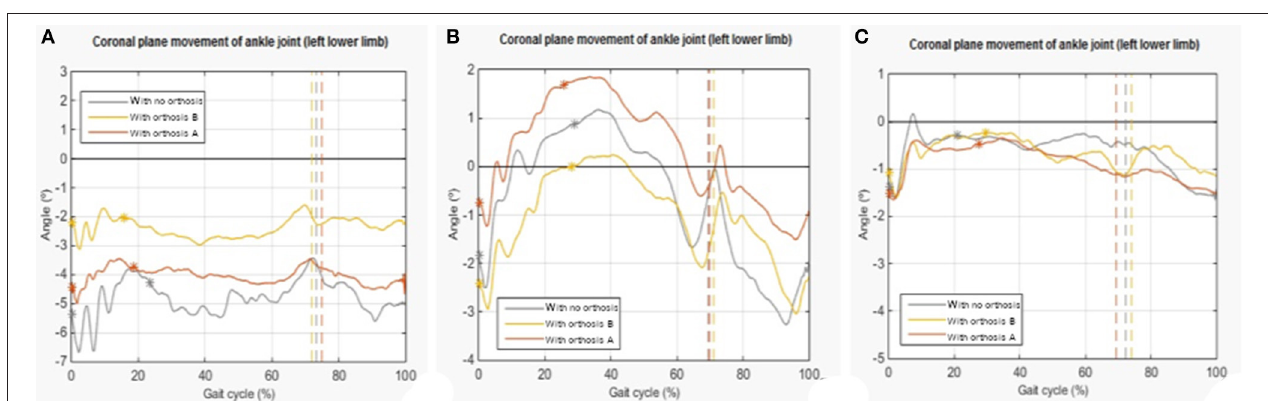
FIGURE 3 | Examples of plots representing the ankle joint’s coronal plane of the pathological lower limb in the three conditions in the analysis. (A) Trial 1 of subject 1. (B) Trial 1 of subject 2. (C) Trial 1 of subject 3. The vertical line presents the contact phase, and the * is the higher value.